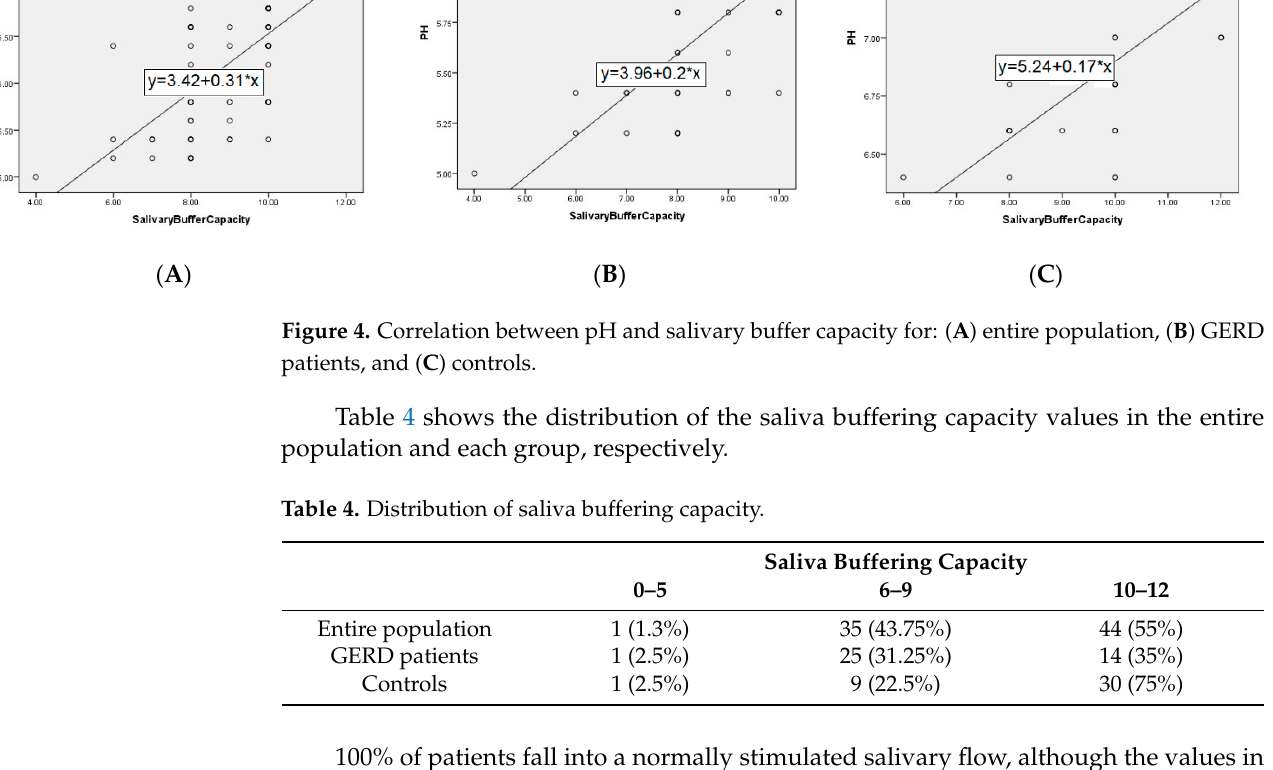
Table 4. Distribution of saliva buffering capacity.